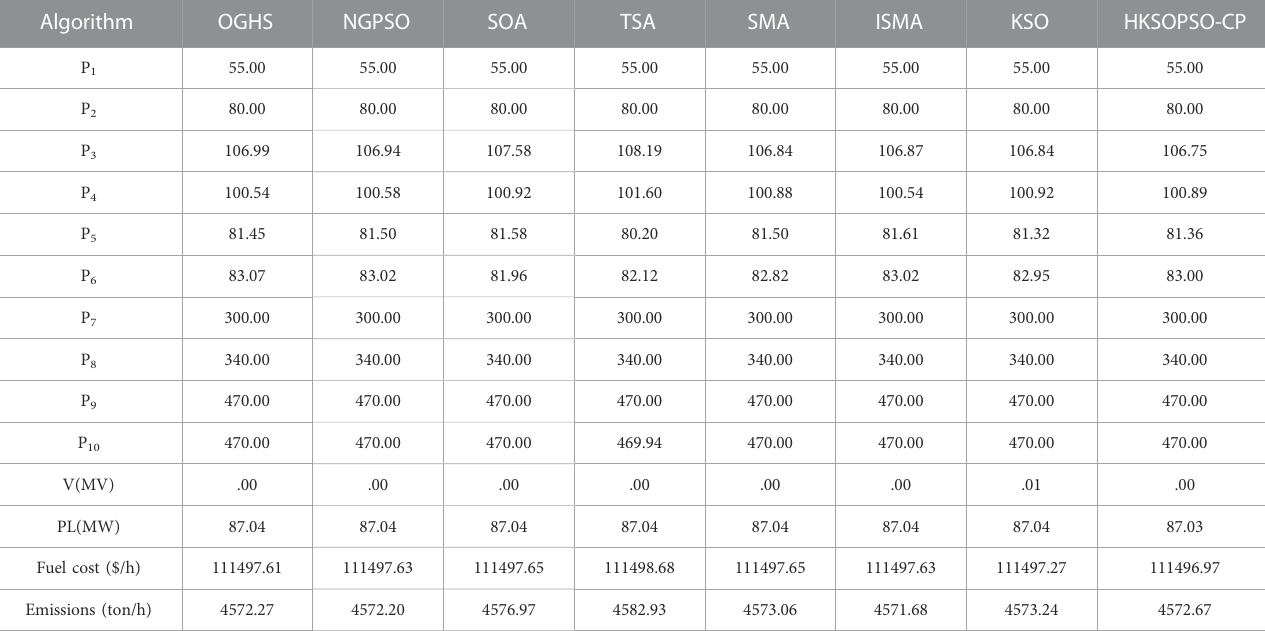
TABLE 8 Case 2 comparison between different algorithms optimizing for fuel cost. Algorithm